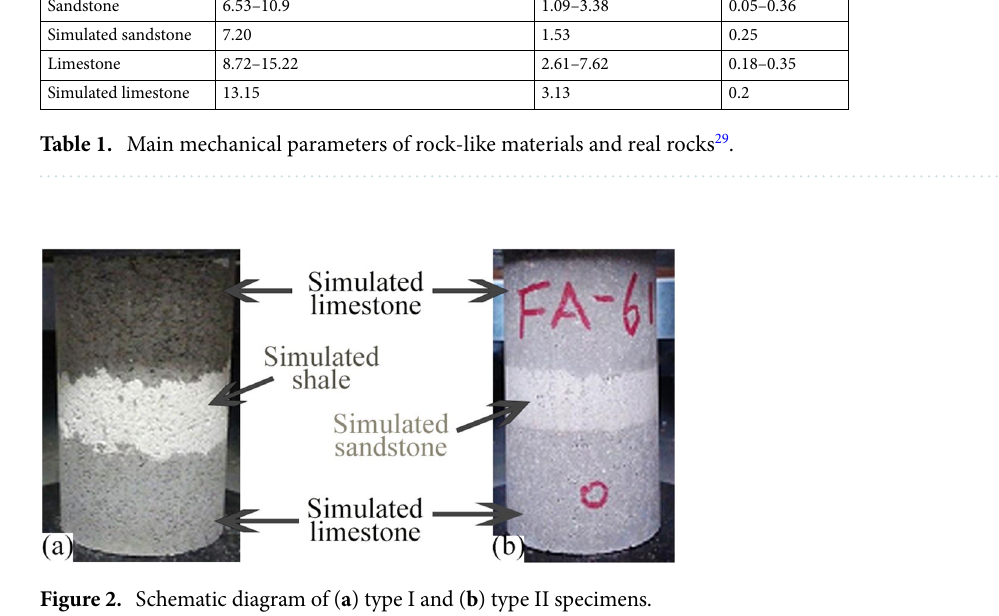
Figure 2. Schematic diagram of ( a ) type I and ( b ) type II